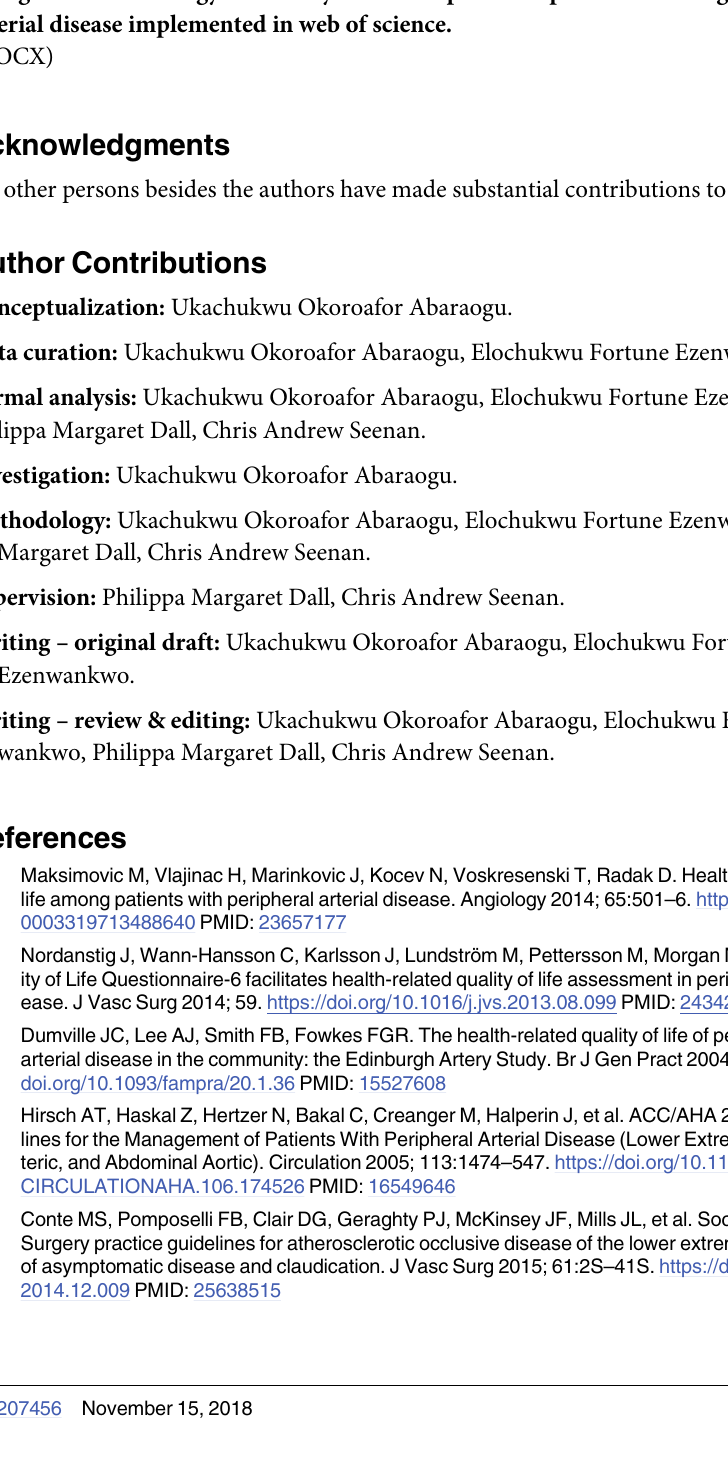
S1 Table. PRISMA 2009 checklist patients experiences of living with peripheral arterial disease. S1 Fig. A search strategy to identify articles of patient experience of living with peripheral arterial disease implemented in web of